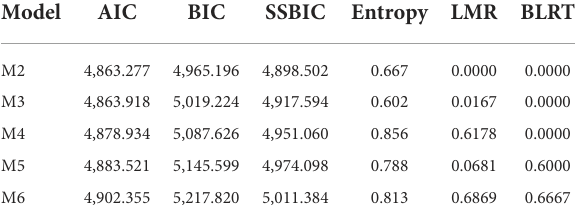
TABLE 3 The goodness of fit of potential class models for classes 2 to 6 ( N = 913).